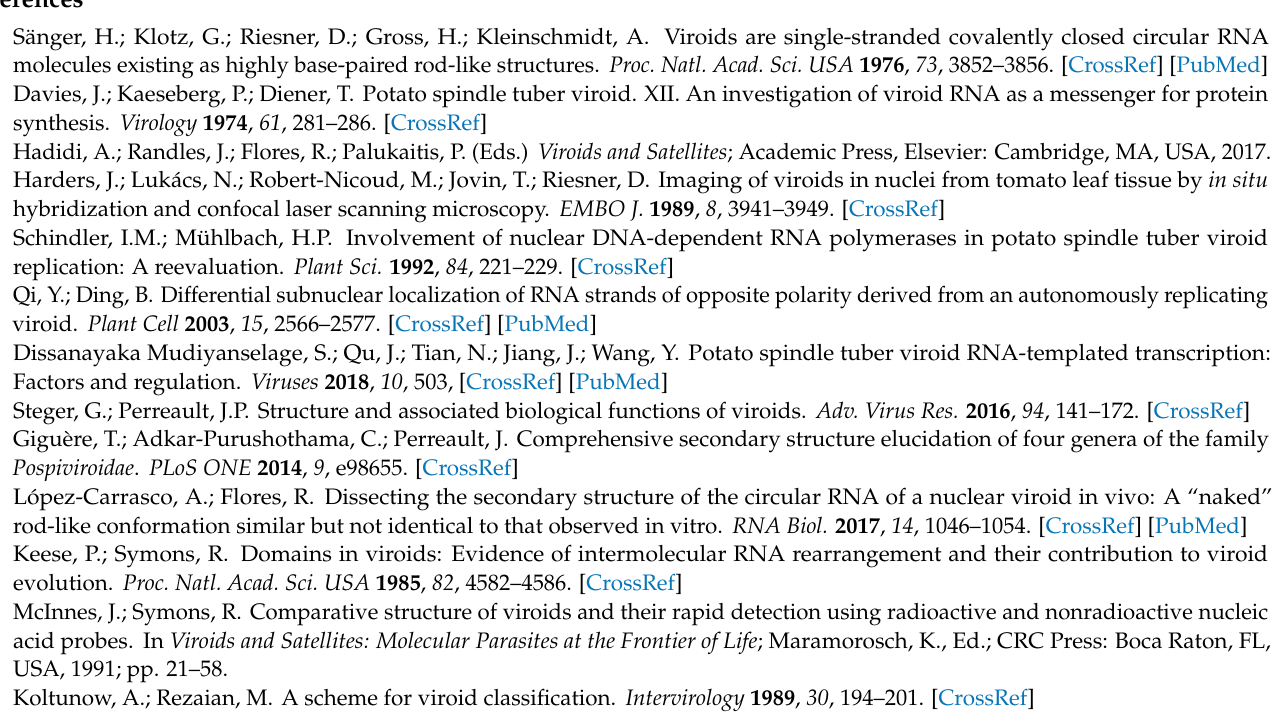
Similarity among Pospiviroid members. Figure S14. Similarity among Apscaviroid members. Figure S15. MAFFT alignment between the consensus sequences of Coleviroid members. Figure S16. Similarity among Coleviroid members. Figure S17. MAFFT alignment between members of the genera Cocad- , Pospi- , and Hostuviroid . Figure S18. MAFFT alignment of DLVd, HSVd, and selected members of Pospiviroid . Figure S19. Similarity among DLVd, HSVd, and selected members of Pospiviroid . Figure S20. Sequence logo of “Terminal Conserved Region” (TCR). Figure S21. Sequence logo of “Terminal Conserved Hairpin” (TCH). Figure S22. Part of the central domain including hairpin I (HPI) based on an alignment of 899 Pospiviroid sequences. Figure S23. Part of the central domain including hairpin I (HPI) based on an alignment of 612 Apscaviroid sequences. Figure S24. LCCR of Apscaviroid members. Figure S25. Hairpin II (HPII) of Pospiviroid sequences. Figure S26. RY motif of Pospiviroid sequences. Supplementary tables: Table S1. Classification of viroids, viroid names, and abbreviations. Table S2. Pairwise sequence identity of the sequences used by Keese and Symons (1985) after alignment with N UC A LN ( k = 4 and g = 4). Table S3. Pairwise sequence identity of the sequences used by Keese and Symons (1985) after alignment with N UC A LN with parameters k = 3 and g = 3. Table S4. Average pairwise sequence identity of consensus sequences of Pospiviroid species after alignment with MAFFT X-INS- I . Table S5. Consistent domain borders of Pospiviroid members. Table S6. Nomenclature for incompletely specified